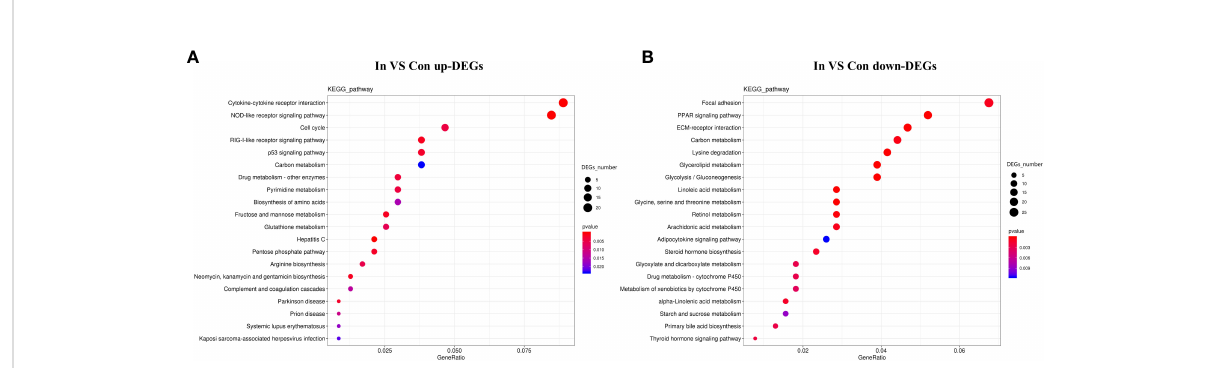
FIGURE 3 KEGG enrichment analysis of DEGs in transcriptome following MSRV infection. (A) KEGG enrichment analysis of up-regulated genes following MSRV infection. (B) KEGG enrichment analysis of down-regulated genes following MSRV